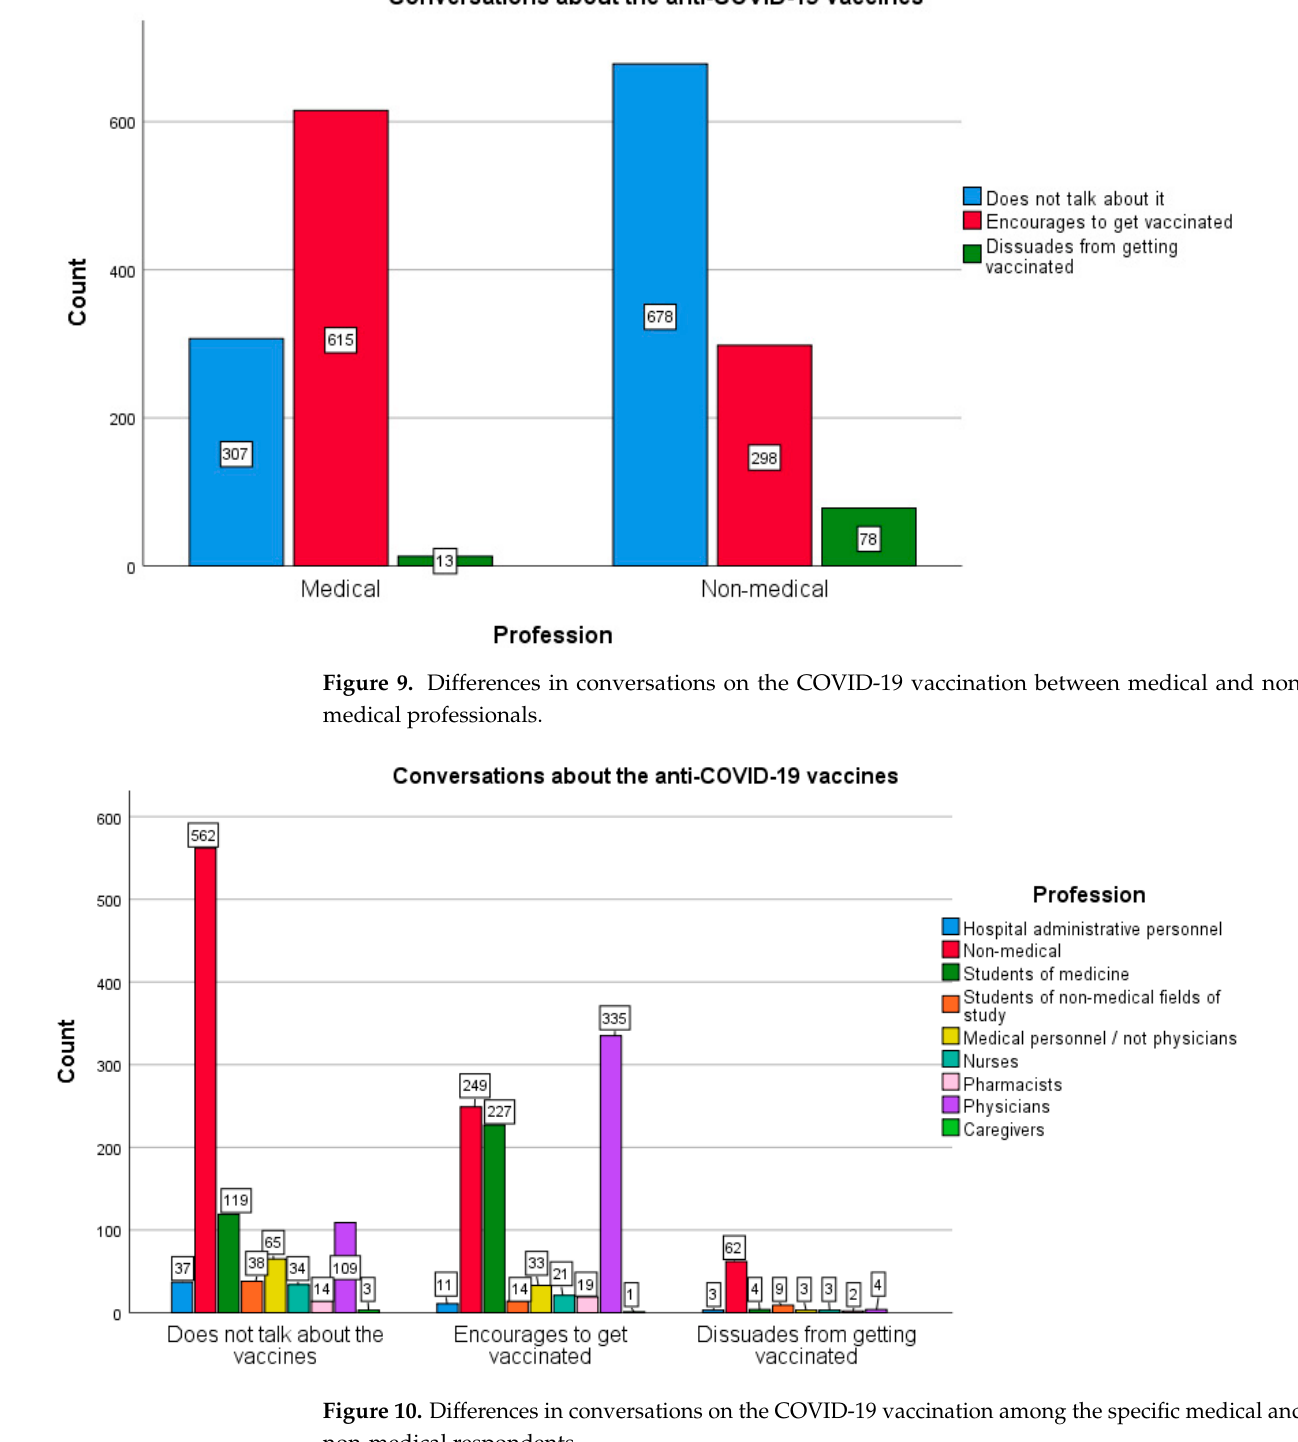
Figure 10. Differences in conversations on the COVID-19 vaccination among the specific medical and non-medical respondents.